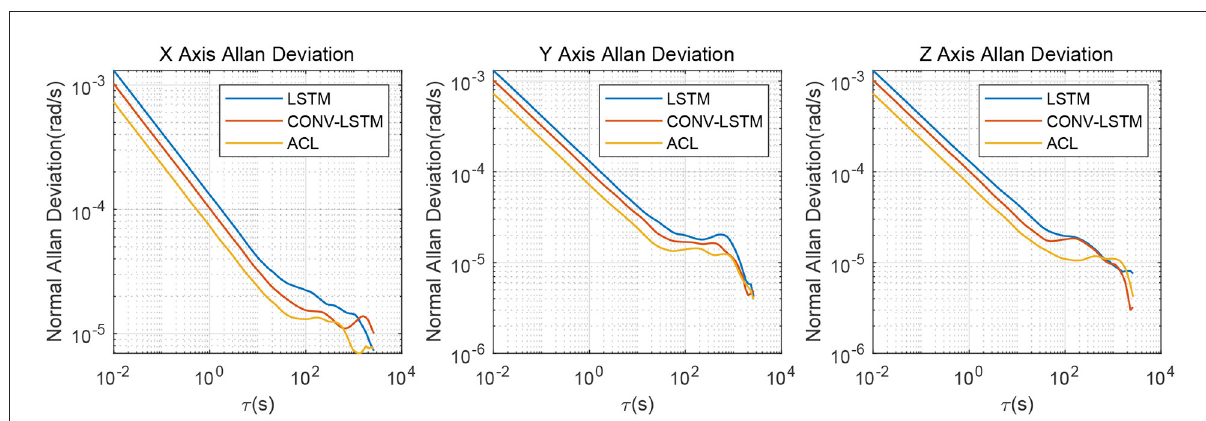
FIGURE11 Allan variance comparison between denoised and raw signals for the ablation study.